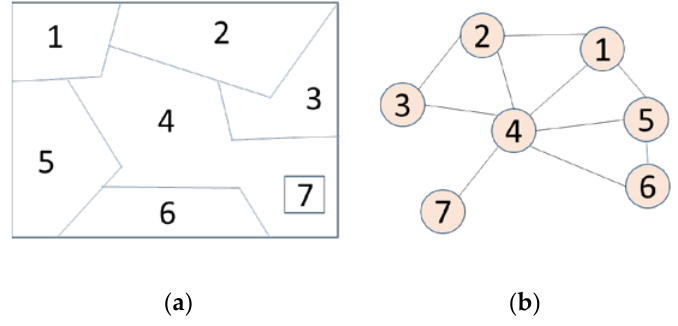
Figure 3. ( a ) Example of region partition; ( b ) The corresponding RAG.